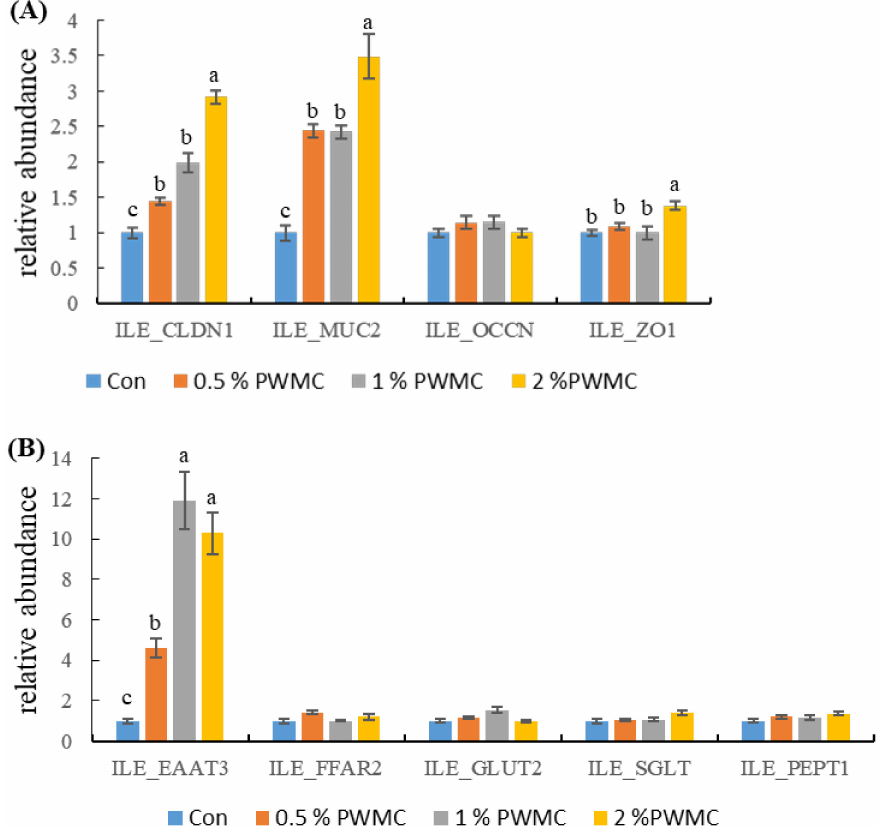
Figure 1. Intestinal barrier ( A ) and nutrient absorption-related ( B ) mRNA expression in the ileum (ILE) for 35-day-old broilers. CLDN: Claudin-1; MUC-2: Mucin2; OCCN: Occludin; ZO-1: Zonula occludens 1; EAAT3: Excitatory amino acid transporter 3; FFAR2: Free fatty acid receptor 2;